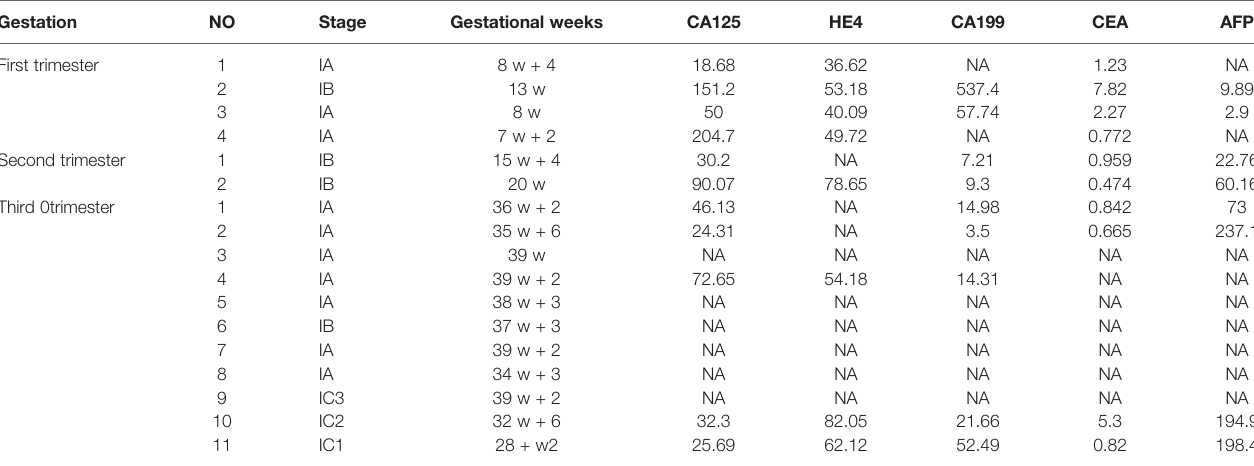
TABLE 1 | Diagnosis of tumor